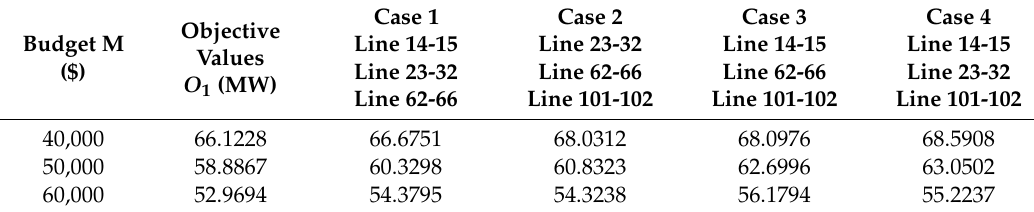
Table 12. Results for three outages on the IEEE 118-bus